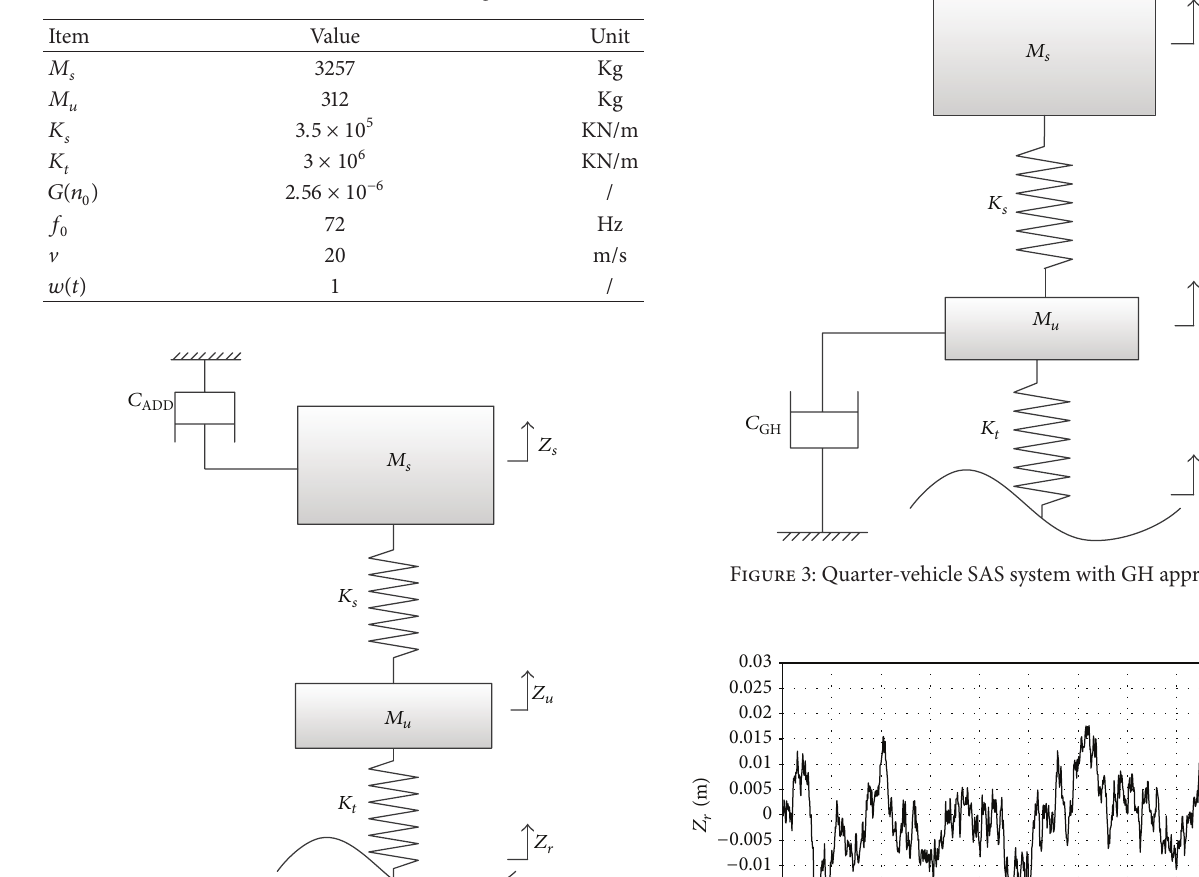
Table 1: Parameters for modeling.